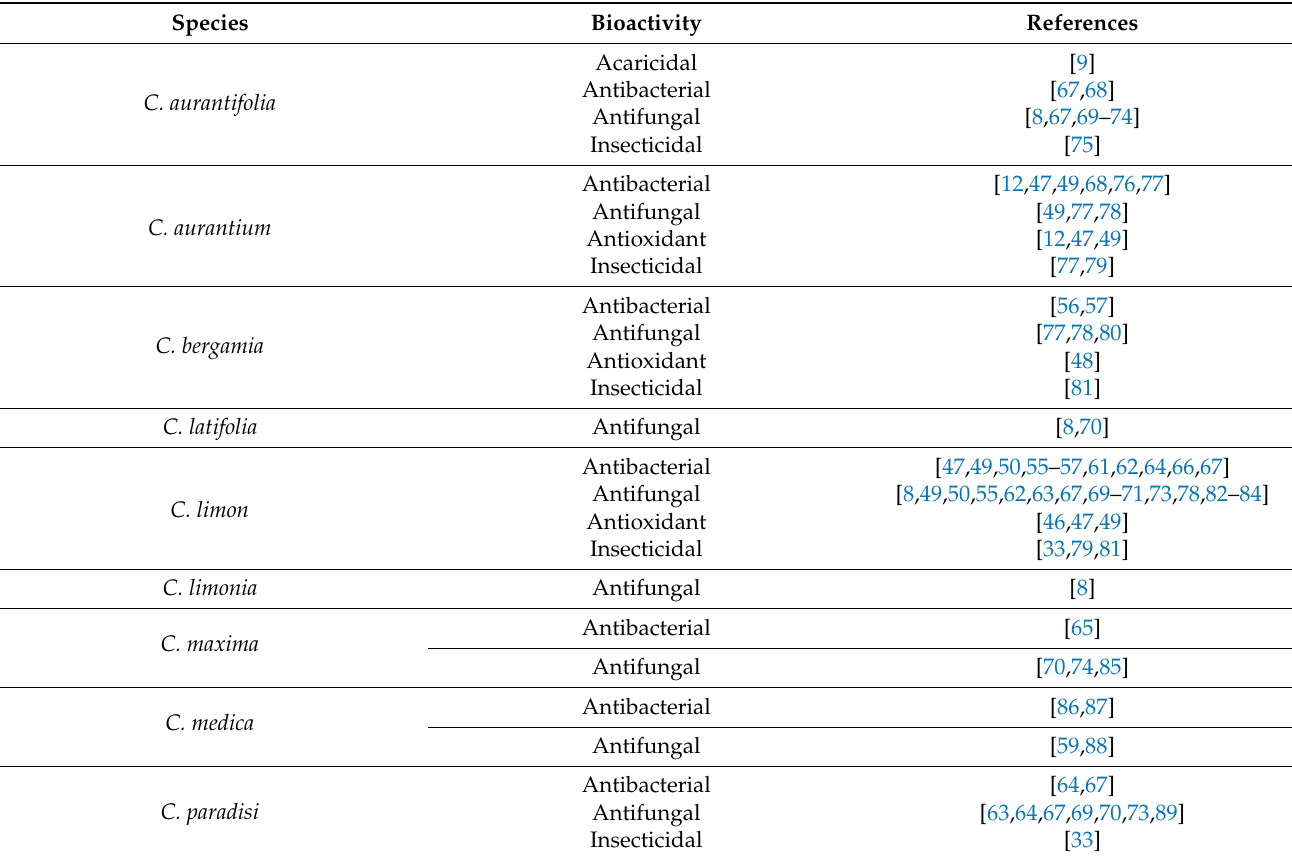
Table 2. Bioactivity of essential oils extracted from citrus peels as related to fruit quality.